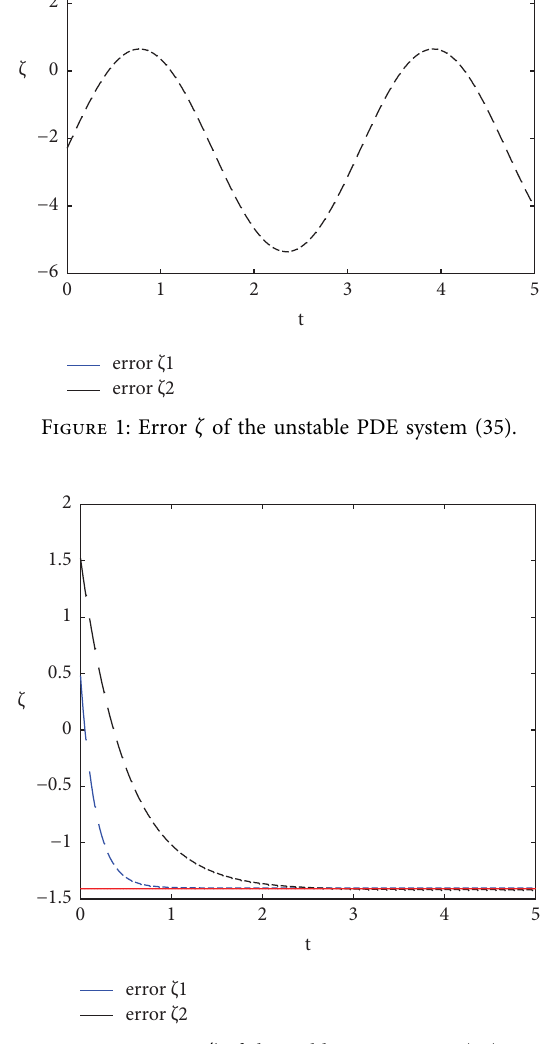
Figure 2: Error ζ of the stable PDE system